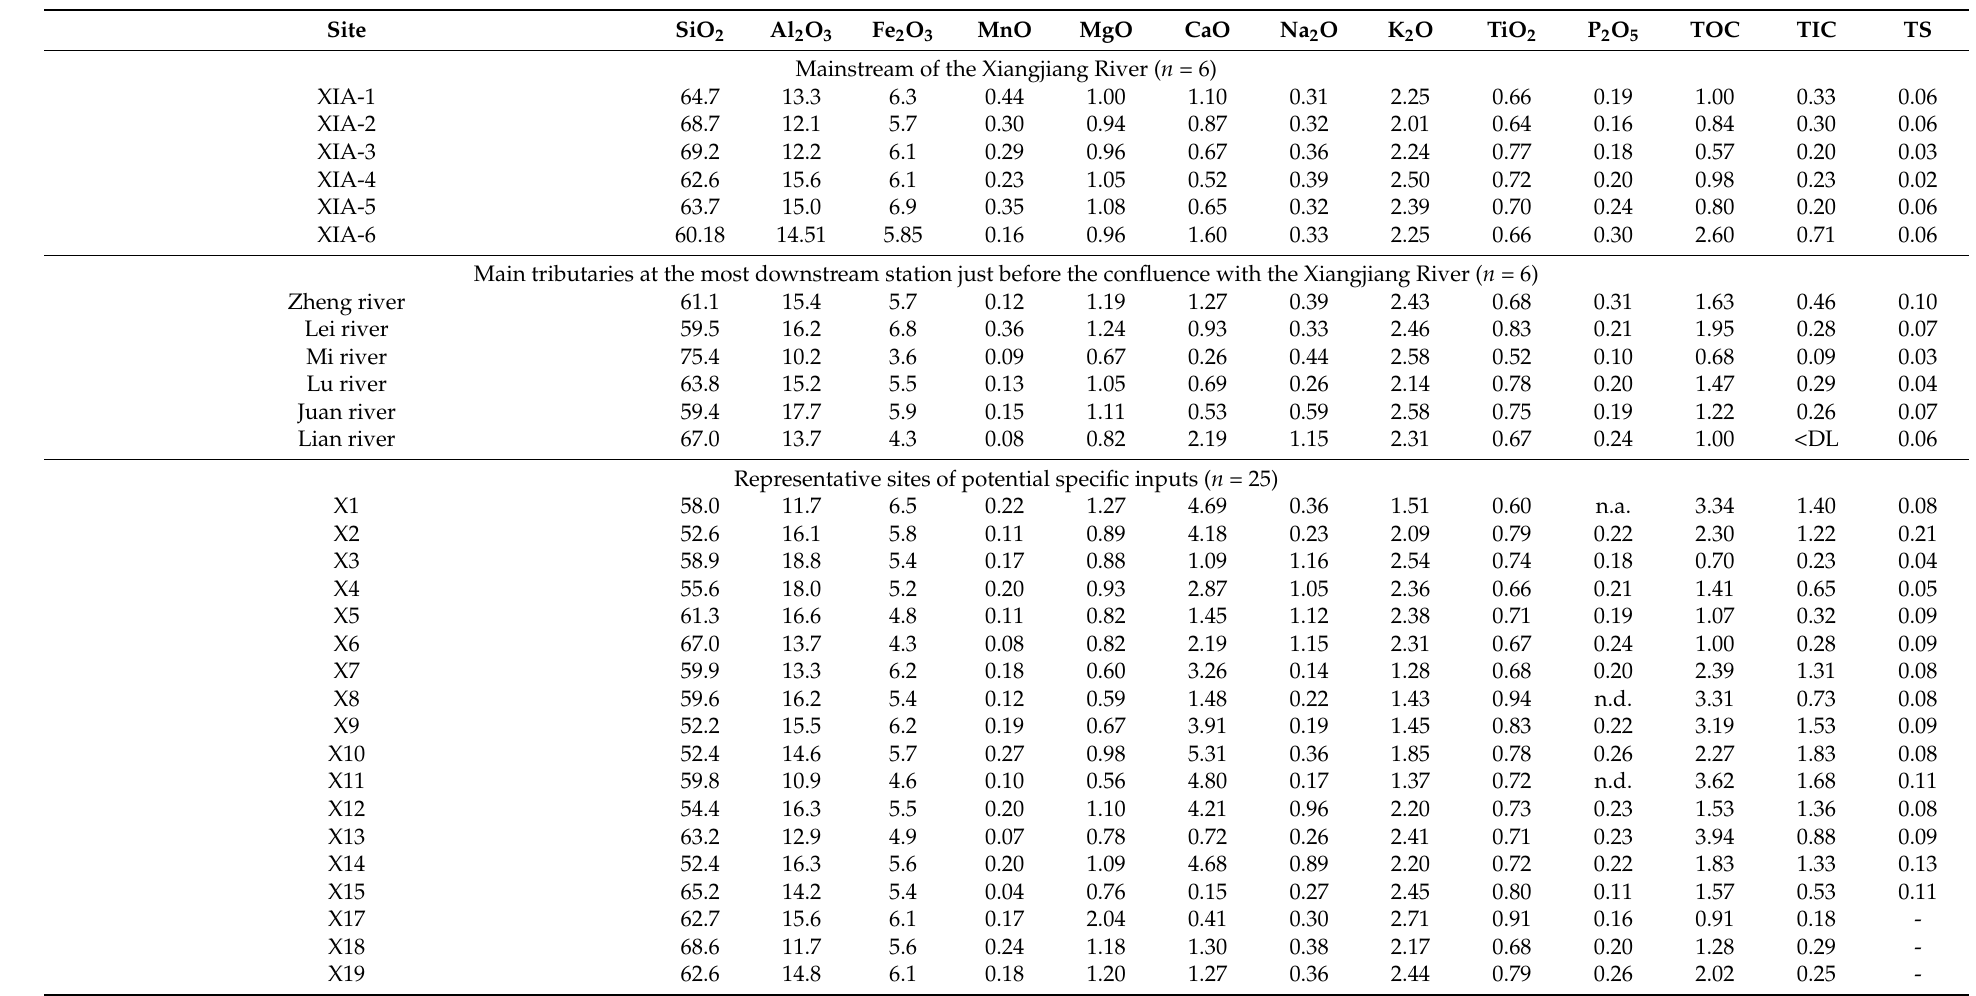
Table 1. Major (%wt) and trace element (mg/kg except Hg in ng/kg) concentrations in the Xiangjiang surface sediments during the 2015–2017 survey.